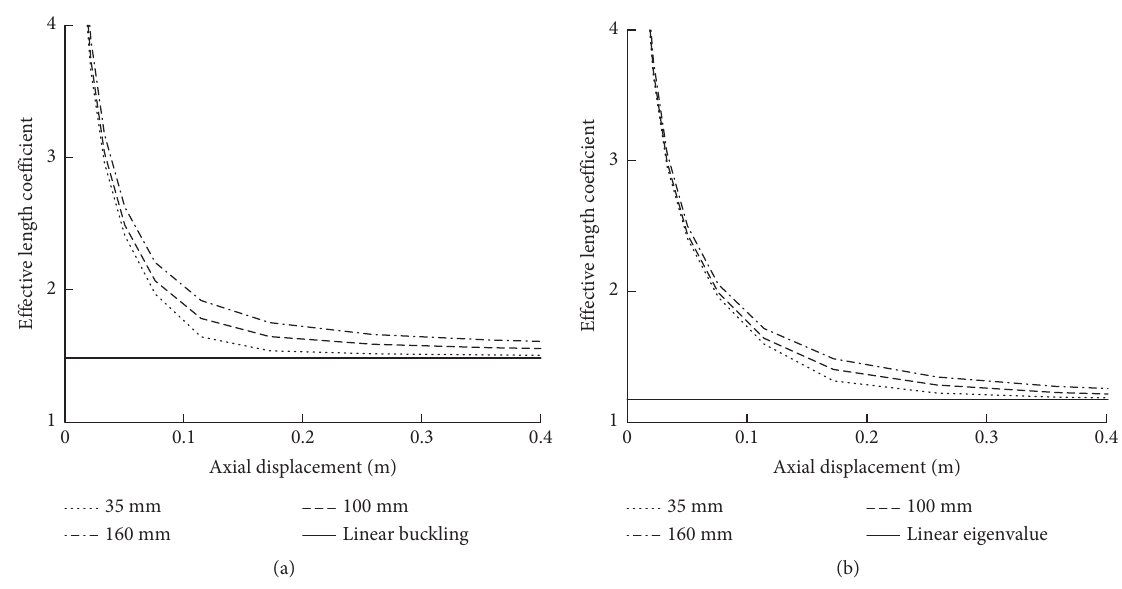
Figure 13: Effective length coefficient of the consistent mode imperfection. (a) Case 1. (b) Case